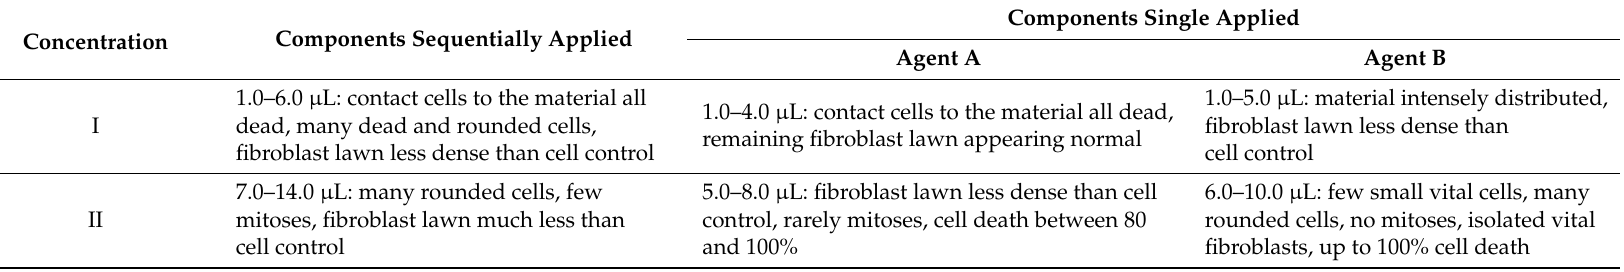
Table 5. Qualitative evaluation: One-up Bond F Plus (No. 2).